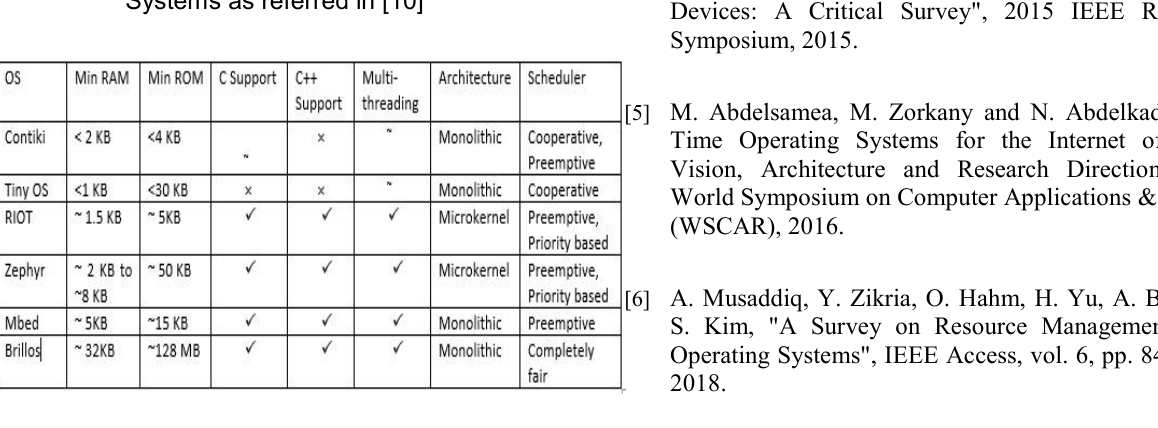
Table 1. Comparison of different IoT Operating Systems as referred in